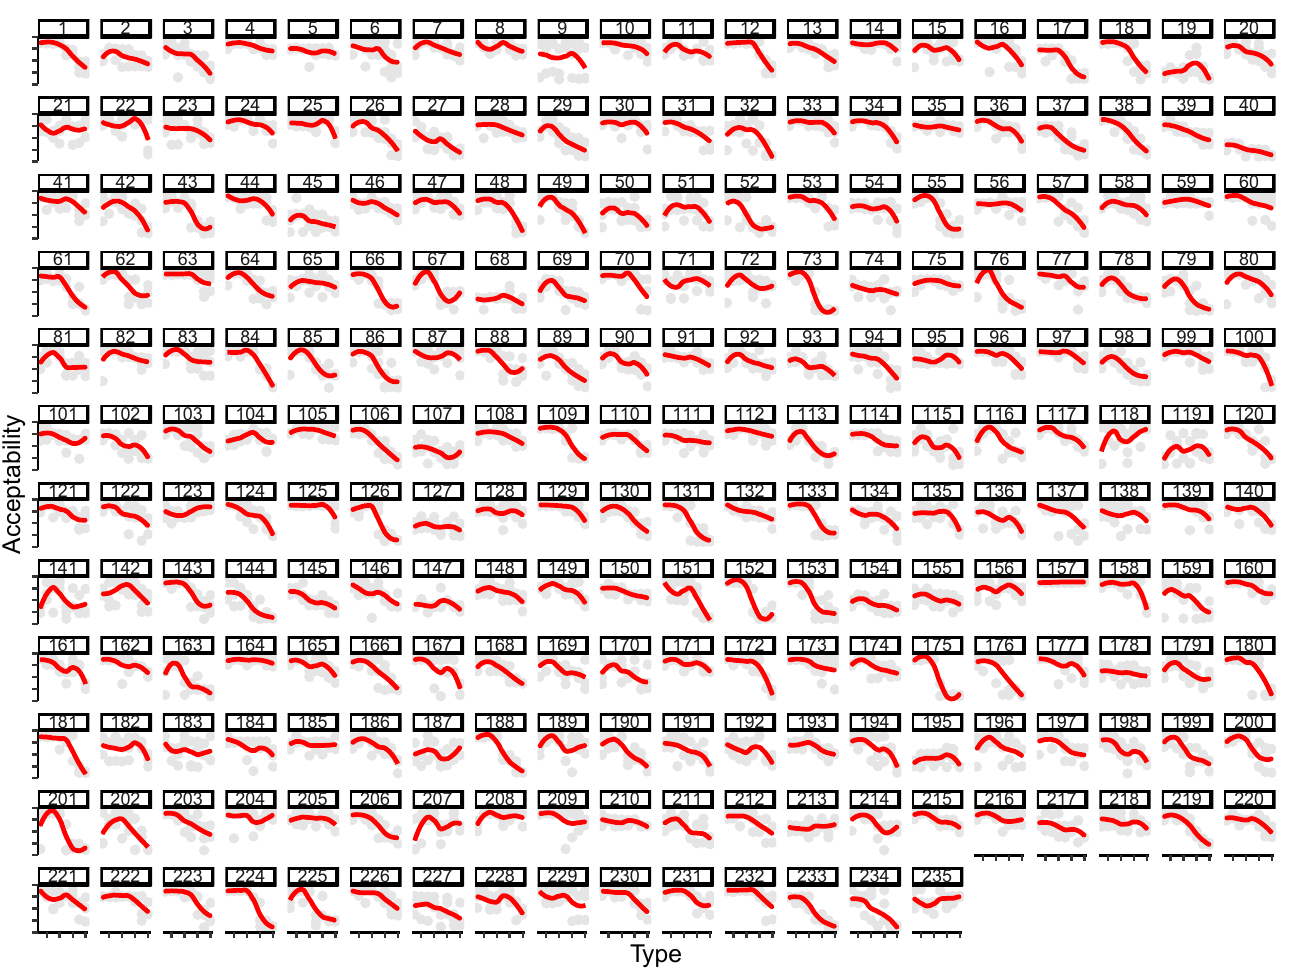
Figure 2. Mean (raw) acceptability ratings by type (see Figure 2) for each of the 24 target sets.